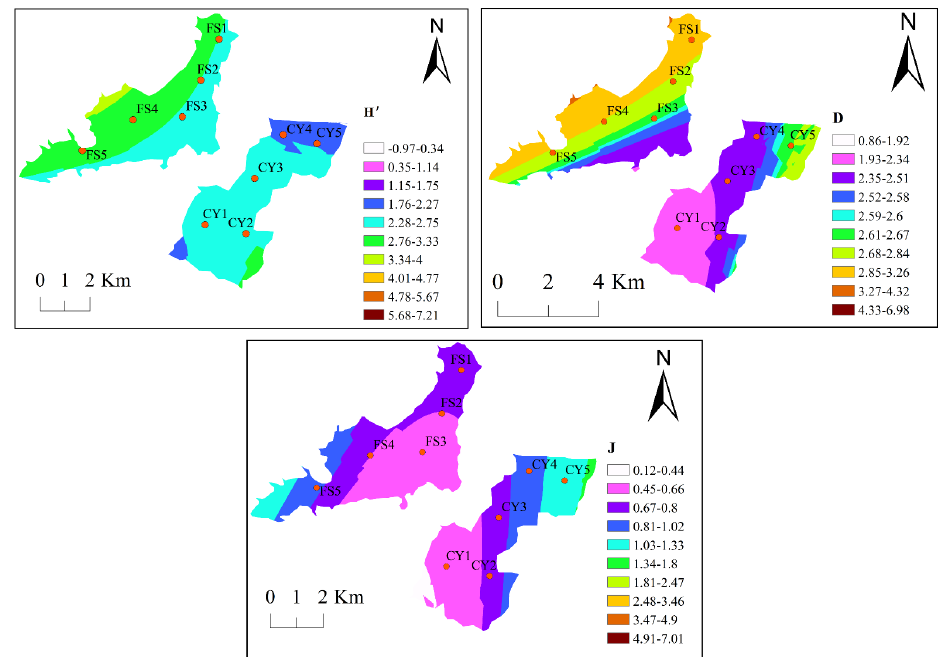
Figure 6. Spatial distribution of zooplankton diversity indices in Lak Chen Yao and Lake Feng Sha.